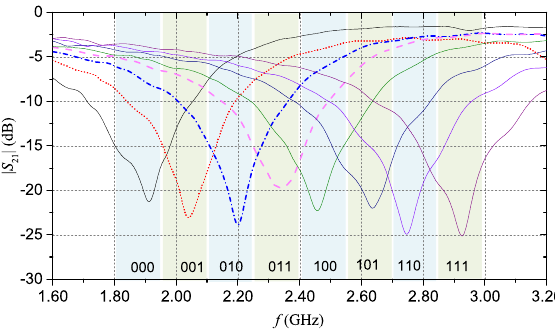
Figure 11. Measurement results of the | S 21 | for the hairpin resonator.